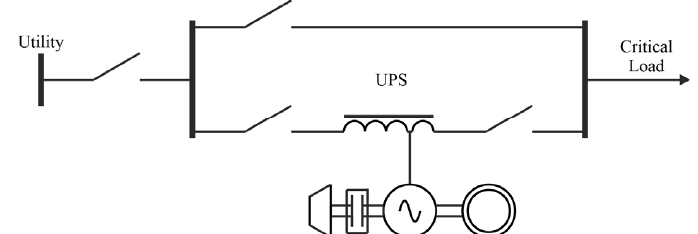
Figure 3. Configuration of the Single System.